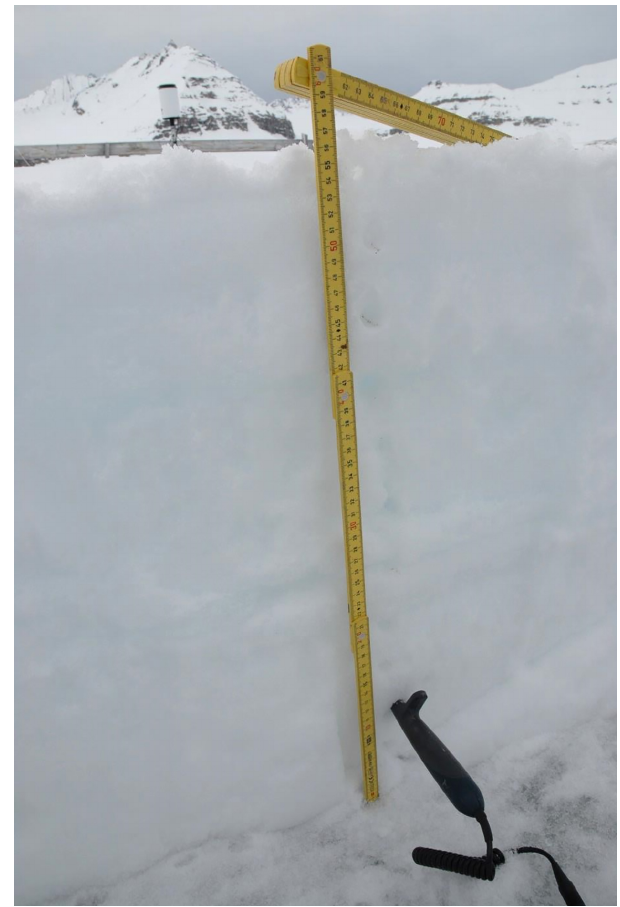
Figure E4. Measuring snow temperature in profile, 10 May 2016. Data can be found in Table